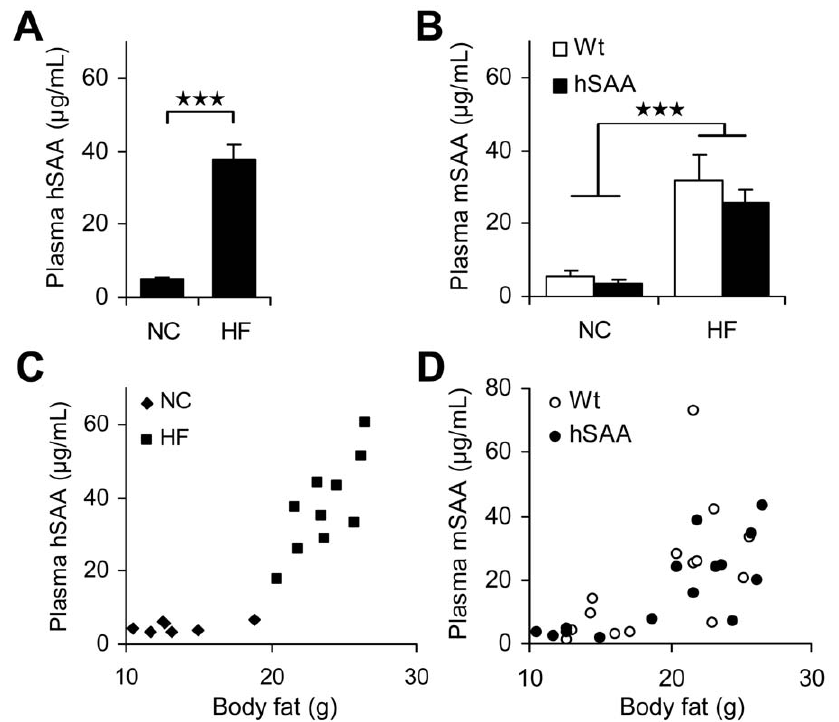
Figure 3. Analyses of SAA plasma levels. ( A ) Plasma levels of hSAA in NC (n=7) compared to HF (n=10) fed male animals. ( B ) Plasma levels of mSAA in NC (wild type (Wt) and hSAA; n=7 and n=6, respectively) and HF fed (Wt and hSAA; n=8 and n=9, respectively) animals. ( C ) Plasma levels of hSAA in relation to body fat quantified using DEXA analysis in transgenic male animals. ( D ) Plasma levels of mSAA in relation to body fat quantified using DEXA analysis in wild type (n=15) and hSAA (n=15) transgenic male animals.***, p , 0.001. Values are given as mean 6 SEM.